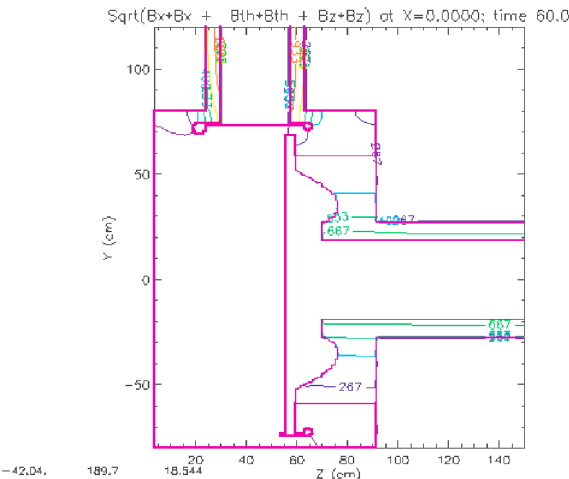
FIG. 22. (Color) LSP model of